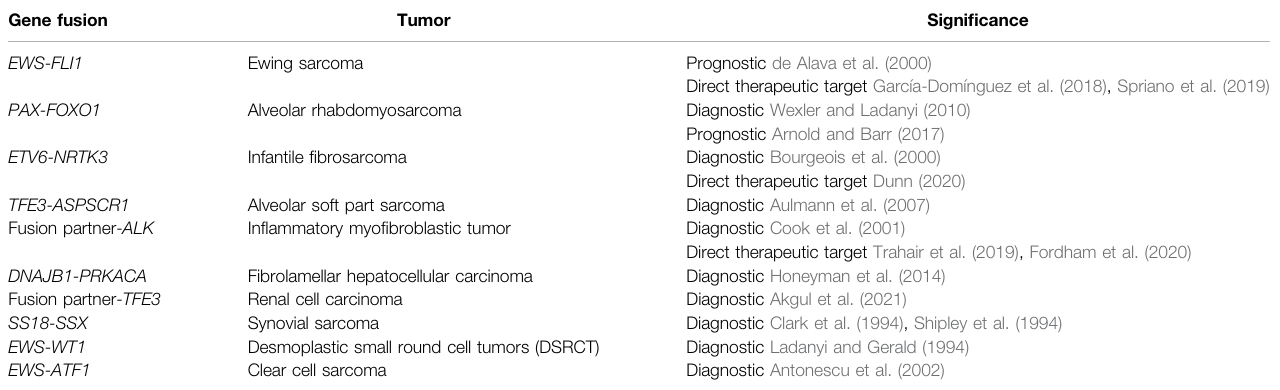
TABLE 1 | Different gene fusions and their corresponding tumor and current signi fi cance(s). Gene